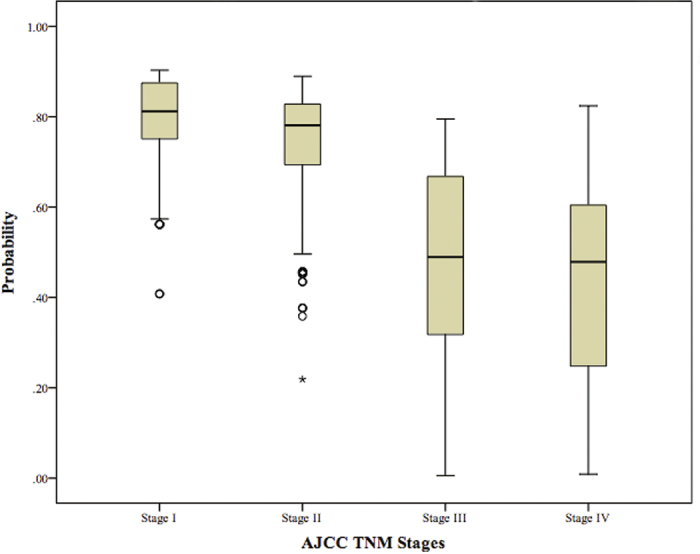
The overall survival probability distribution of different AJCC stages.